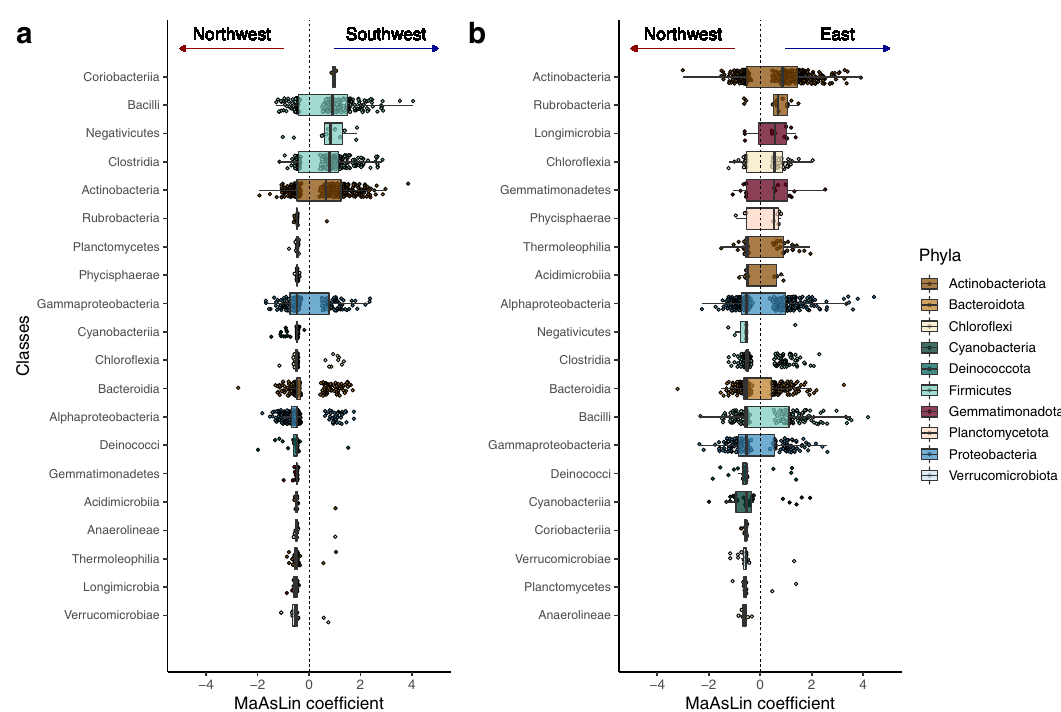
Fig. 3 Bacterial taxa signi fi cantly associated with different air masses. The MaAslin2 scores per class is presented with association to the NW and the SW ( a ), and the NW and the East ( b ) trajectories. Each color represents a different phylum. Box plot center lines represent the median values, the lower and upper hinges correspond to the fi rst and third quartiles (the 25th and 75th percentiles), the lower and upper whisker extends from the hinge to the lowest and largest value no further than 1.5 * IQR from the hinge, and dots represent ASVs within each group. Bacterial classes with more than ten ASVs associated with one of the air masses are shown.